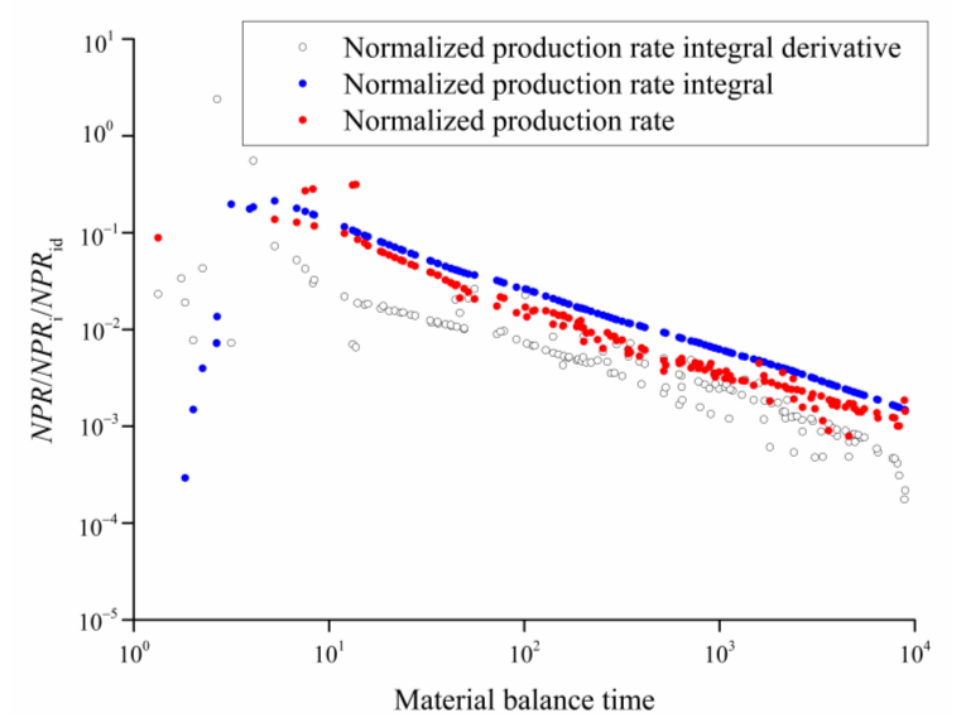
Figure 8. Blasingame production decline typical curve of the single well corresponding to PNR-MBT method.